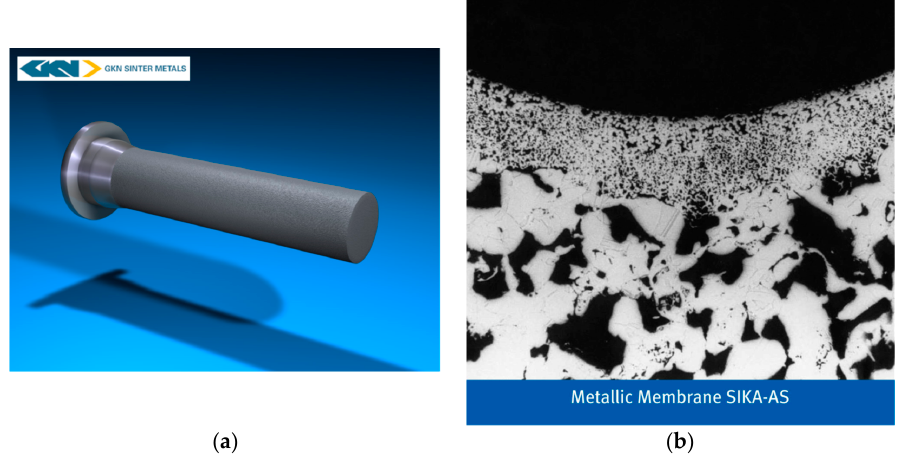
Figure 6. SS-based porous metal membranes from GKN [96]: ( a ) high porous SS filter (the outer surface of the filter has an effective layer of 0.2 mm with a typical length of 1500 mm and an outer diameter of 64 mm, flow configuration: outside-inside); ( b ) metal membrane coating (~200 µm thick) on porous SS filter. Reproduced with permission from GKN.